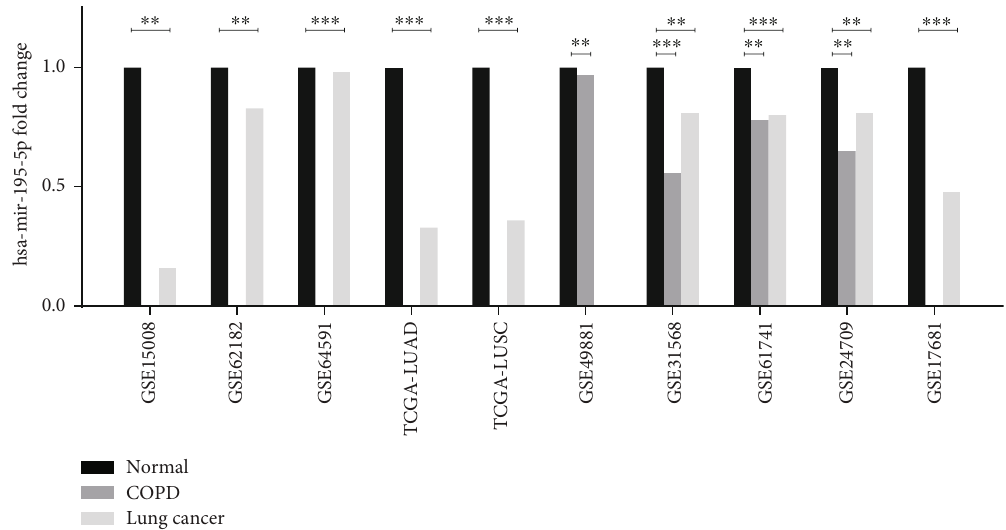
Figure 1: Expression of hsa-miR-195-5p in lung cancer patients, COPD patients, and normal controls. All datasets show higher expression of hsa-miR-195-5p in lung cancer and COPD patients compared with normal controls. Because of the absence of samples, some datasets do not contain all three population